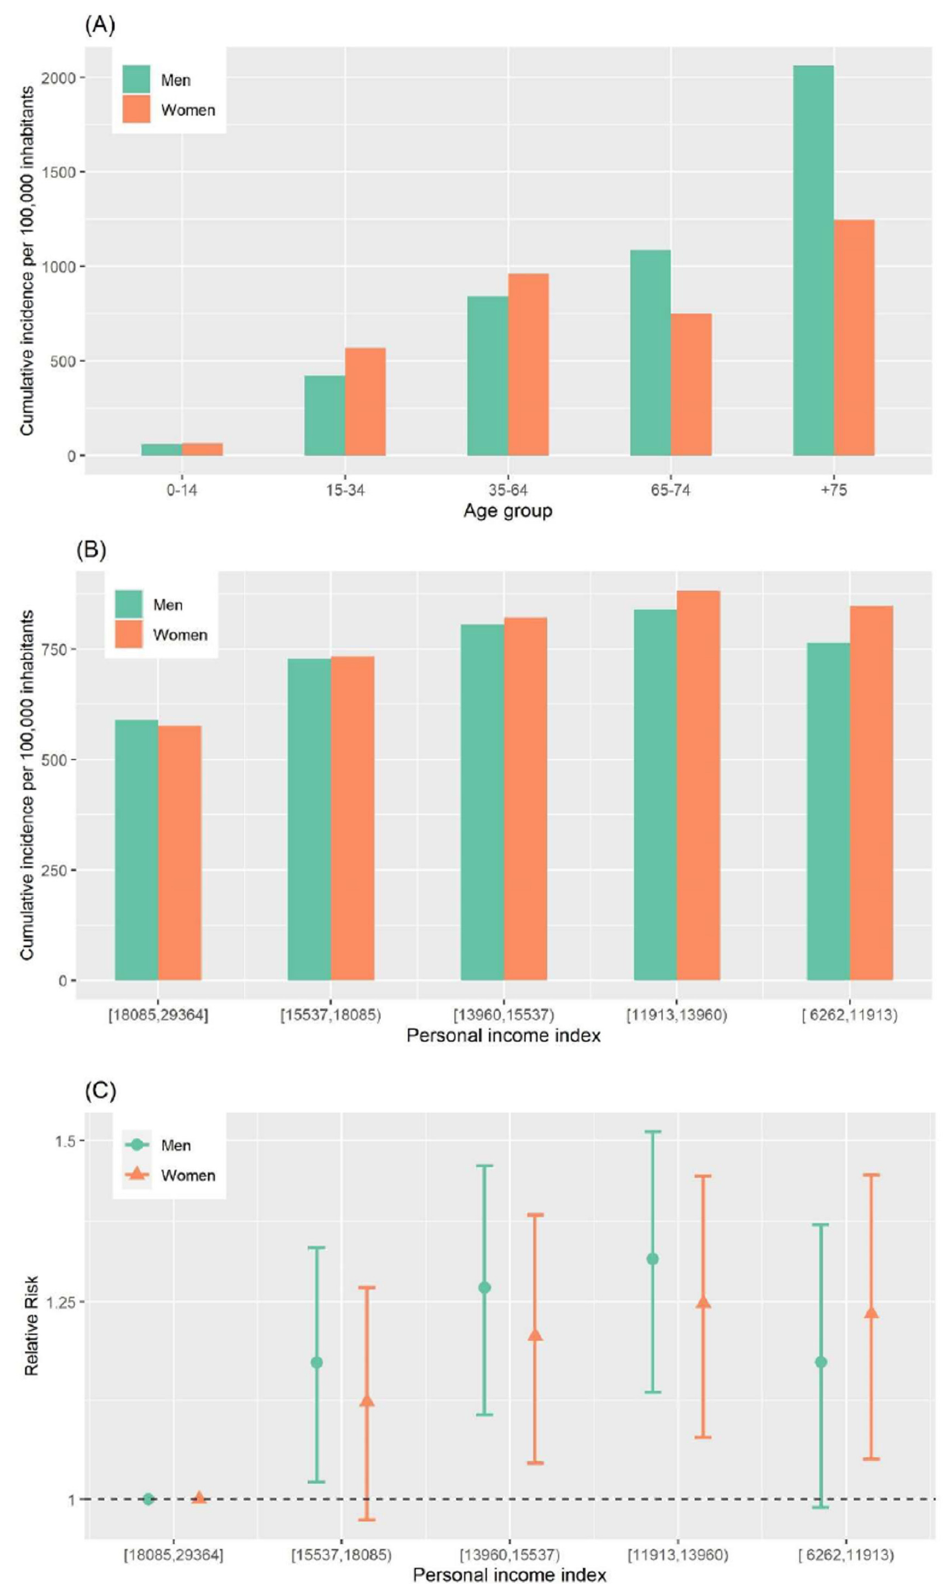
Figure 1. ( A ) Cumulative incidence of COVID-19 per 100,000 inhabitants for each age group and sex; ( B ) Cumulative incidence of COVID-19 per 100,000 inhabitants for each income group (based on personal income index in Euros) and sex; ( C ) Relative risk for each income group and sex. Period from 1 March to 15 July 2020 in Barcelona